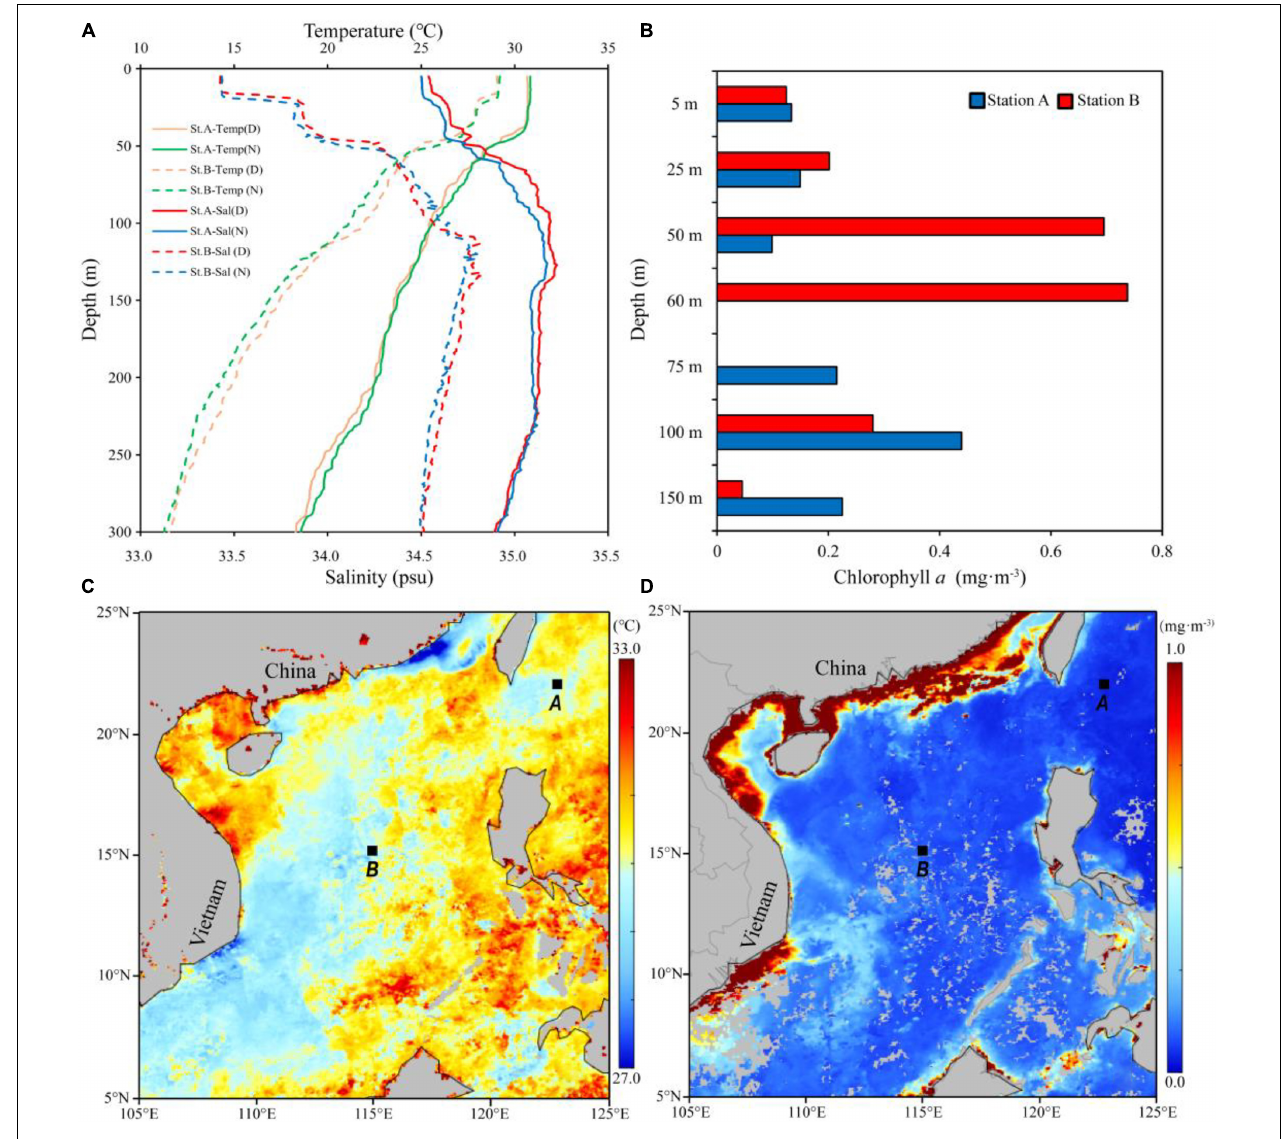
FIGURE 2 | Vertical profile of temperature and salinity above 300 m at stations A and B (A) (Temp, temperature; Sal, salinity; D, daytime; N, nighttime). Vertical distribution of Chl a concentration above 150 m at stations A and B (B) . Surface sea temperature (C) and Chl a concentration (D) based on satellite data (Date: 01–31 July 2017).